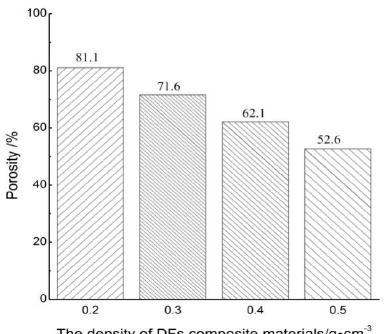
Figure 5. Porosity of the composites with different densities.